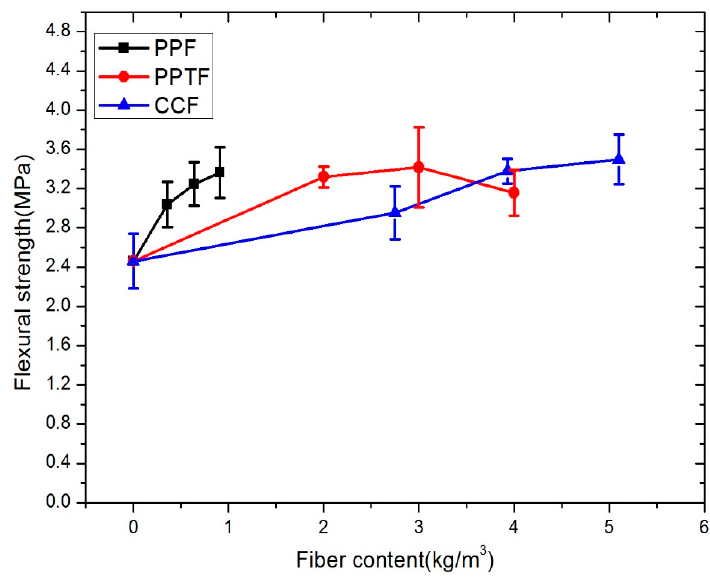
Figure 9. Influence of fiber types and content on flexural strength.